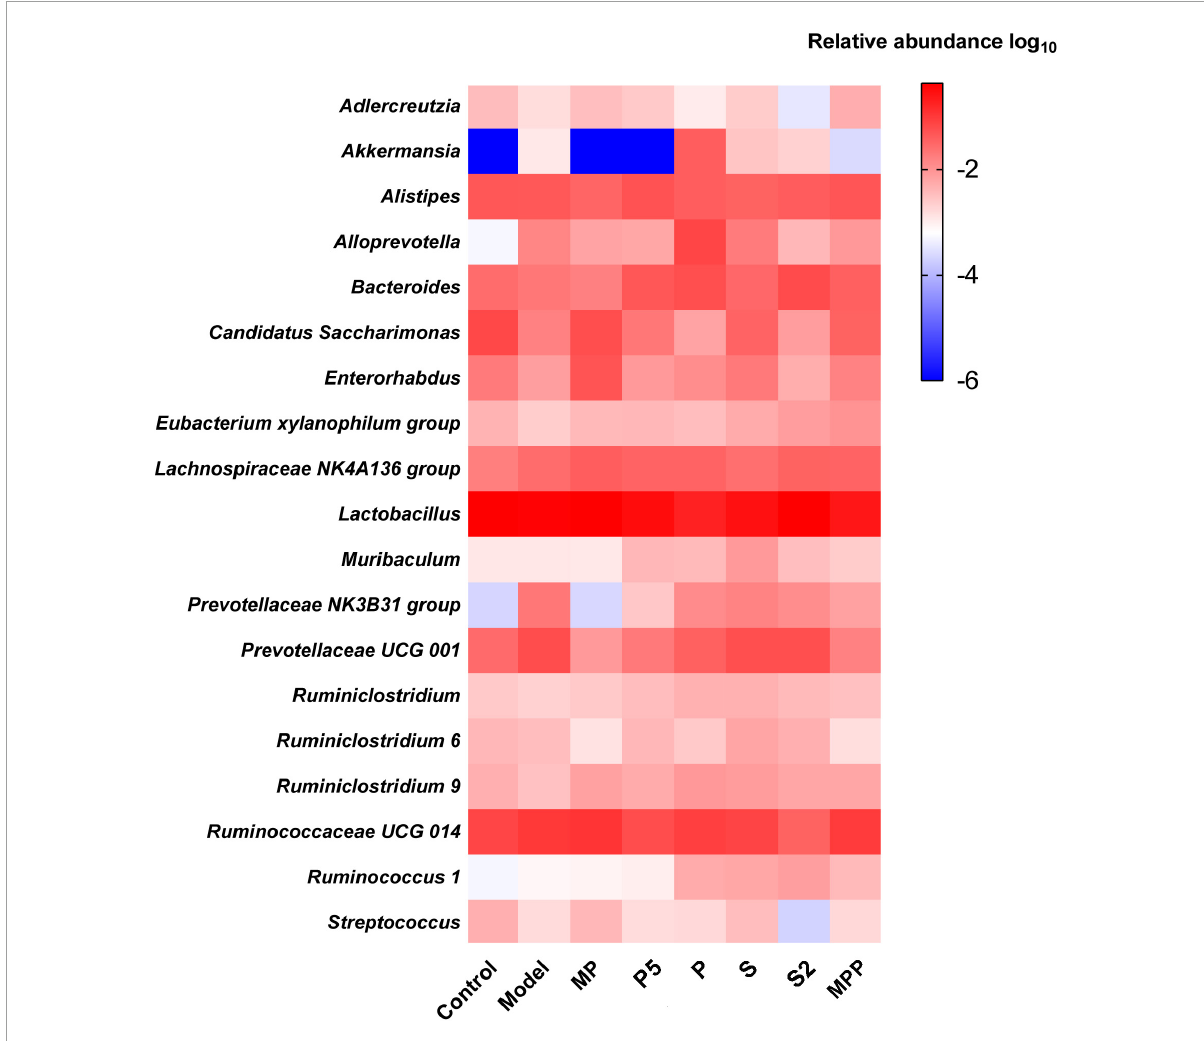
FIGURE5 Heatmap of the top 20 fecal microbial genera among